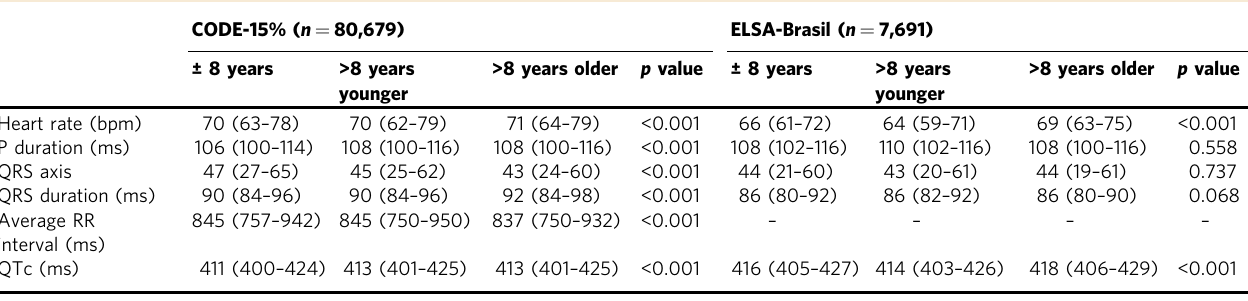
Electrocardiographic age and cardiovascular risk factors . Fig- ure 3a represents which cardiovascular risk factors were most likely associated with a predicted ECG-age more than 8 years greater than the chronological age considering all ECGs from ELSA-Brasil cohort. After logistic regression adjusted for age and sex, hypertension, diabetes, smoking, and obesity remained sig- ni fi cantly associated with an increased odds of having an ECG- age more than 8 years greater than the chronological age. In Fig. 3b the same model was applied only to participants with a normal ECG. Hypertension, diabetes, and smoking were sig- ni fi cantly associated with a predicted ECG-age more than 8 years greater than the chronological age.